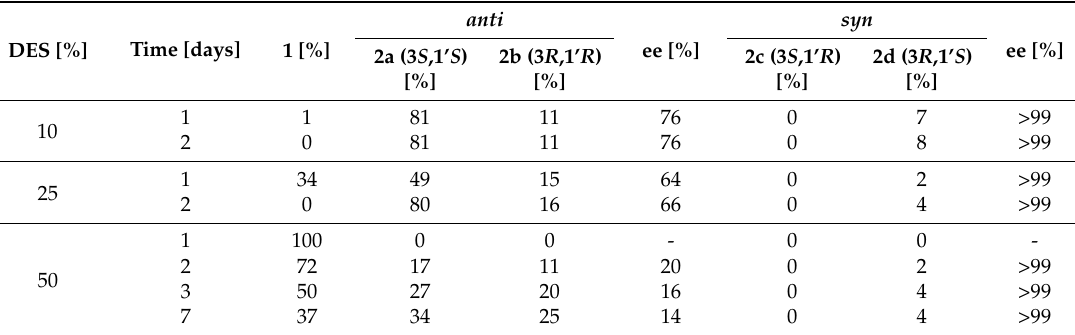
Table 6. The biotransformation of α -acetylbutyrolactone 1 by Candida viswanathi AM120 strain in presence of different amount of deep eutectic solvent (DES) (choline chloride and glycerol 1:2) (in % according to